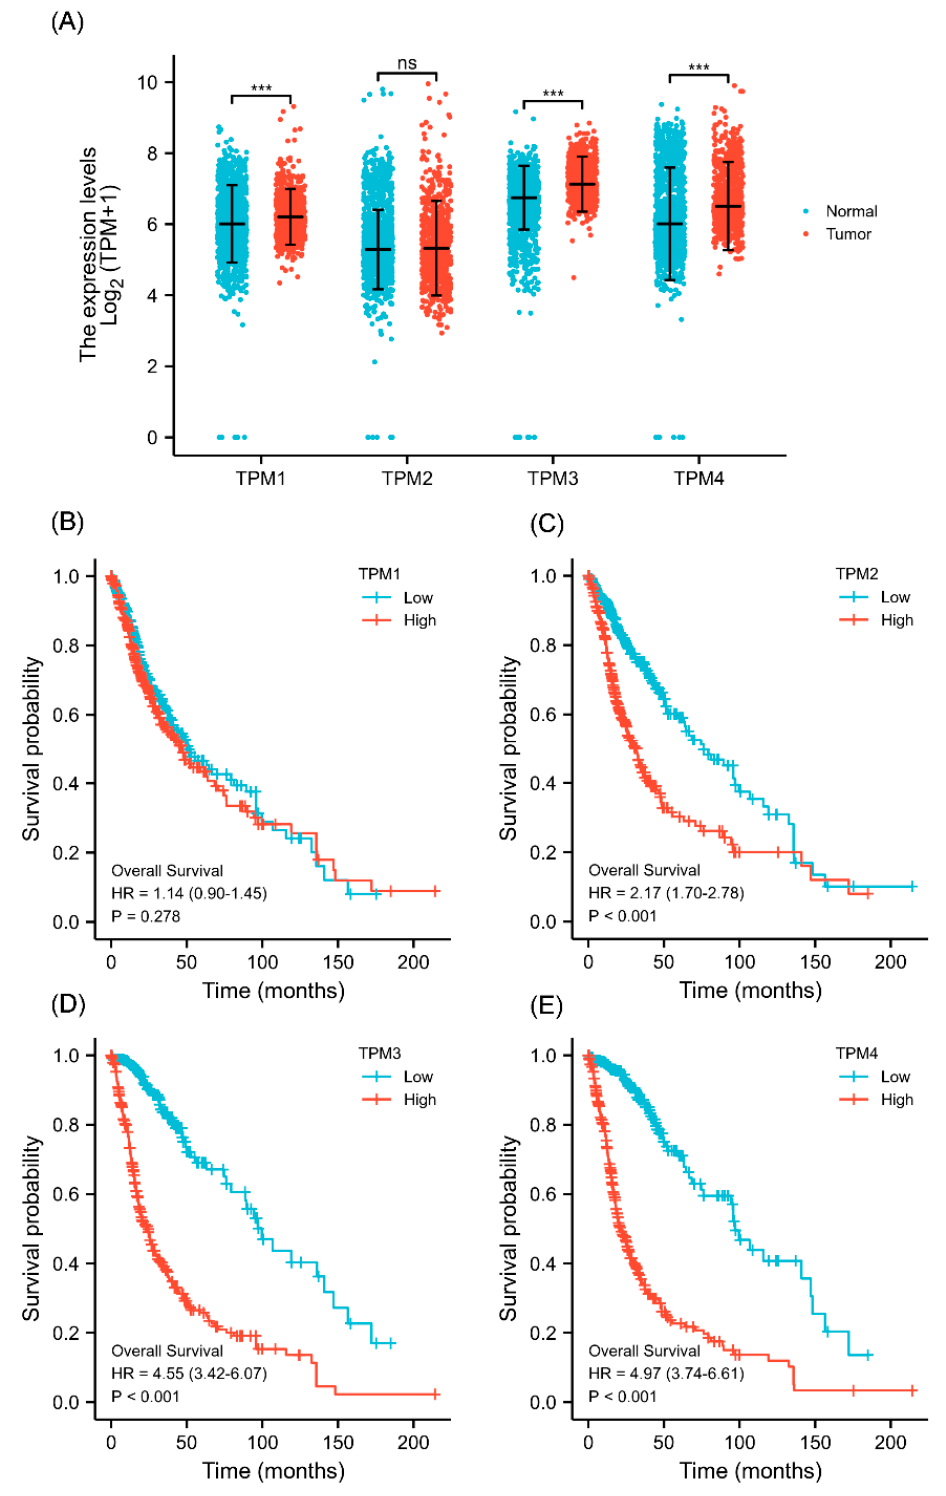
Figure 1. The TPM expressions and survival analyses in gliomas. ( A ) The differential expression analyses of TPMs in glioma patients. ( B ) KM curves of the associations between TPM1 expression and overall survival. ( C ) KM curves of the associations between TPM2 expression and overall survival. ( D ) KM curves of the associations between TPM3 expression and overall survival. ( E ) KM curves of the associations between TPM4 expression and overall survival. (ns, no significance; ***, p < 0.001).